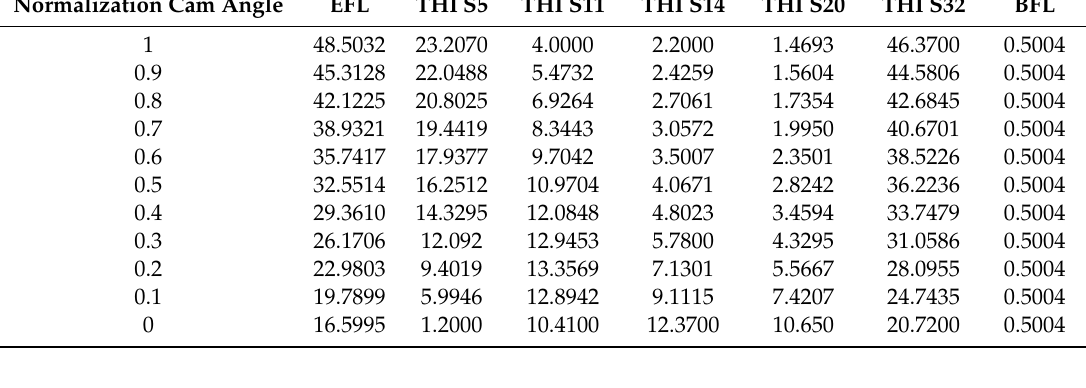
Table 7. Results of reapplying the Padé approximation to results in Table 6.